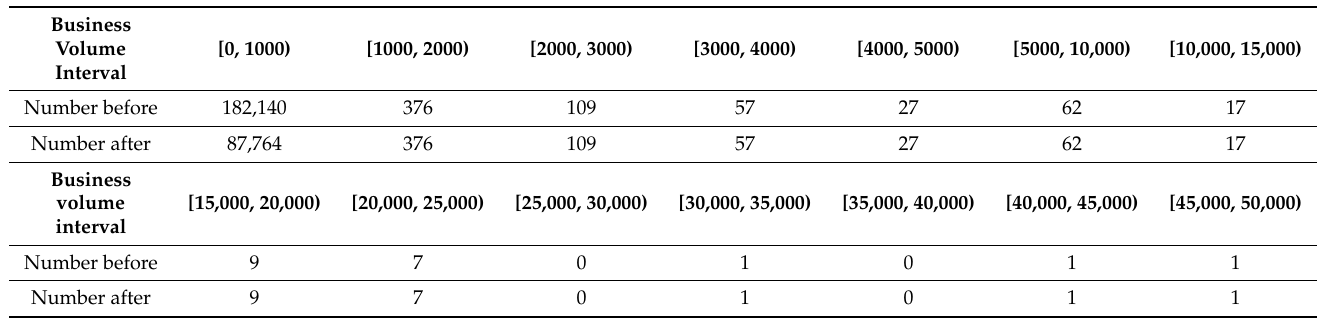
Table 3. Comparison of business volume interval and number of weak coverage points before and after data processing.